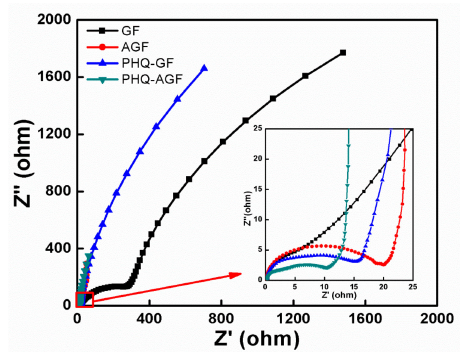
Figure 7. EIS curves (in the form of Nyquist plots) of the different anodes after